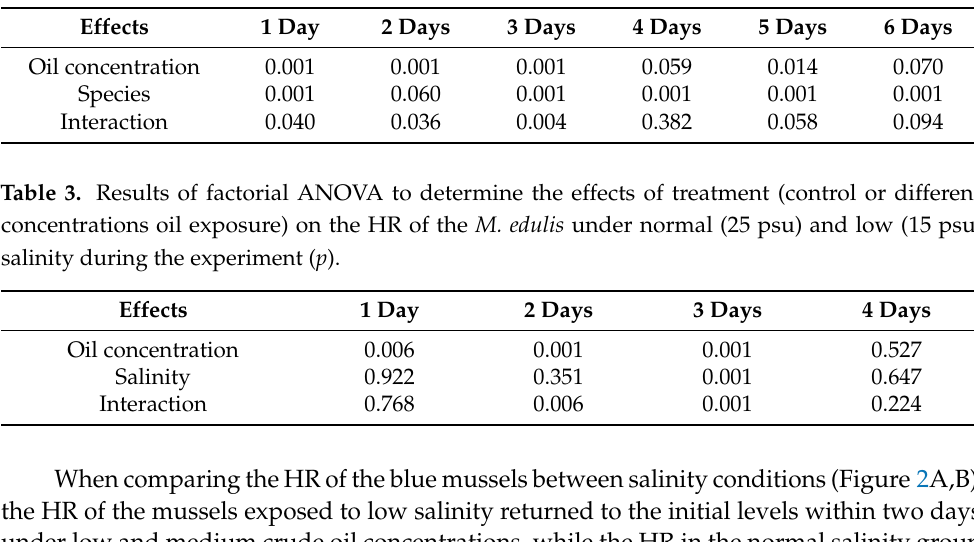
Table 2. Results of factorial ANOVA to determine the effects of treatment (control or different concentrations oil exposure) on the HR of the M. edulis and M. modiolus during the experiment ( p ).